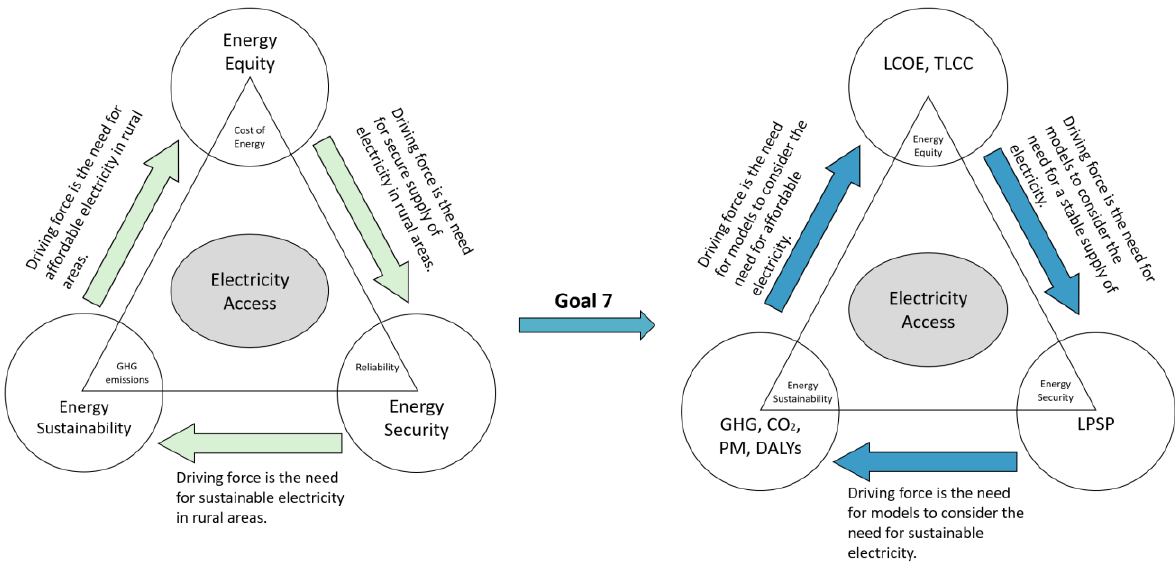
Figure 3. Model considerations based on SDG7: Relation between ETI driving forces ( left ) and model equations ( right ).